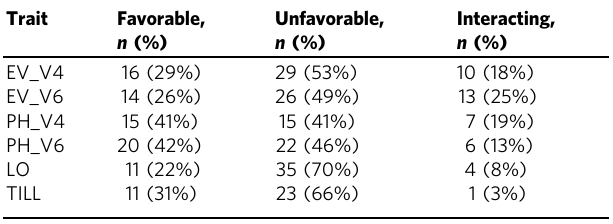
Haplotypes with consistent effect direction across environments were categorized as favorable or unfavorable. For EV_V4, EV_V6, PH_V4, and PH_V6 positive (negative) effects were de fi ned asfavorable(unfavorable).ForLOandTILLnegative(positive)effectswerede fi nedasfavorable (unfavorable). Haplotypes with changing effect direction were categorized as